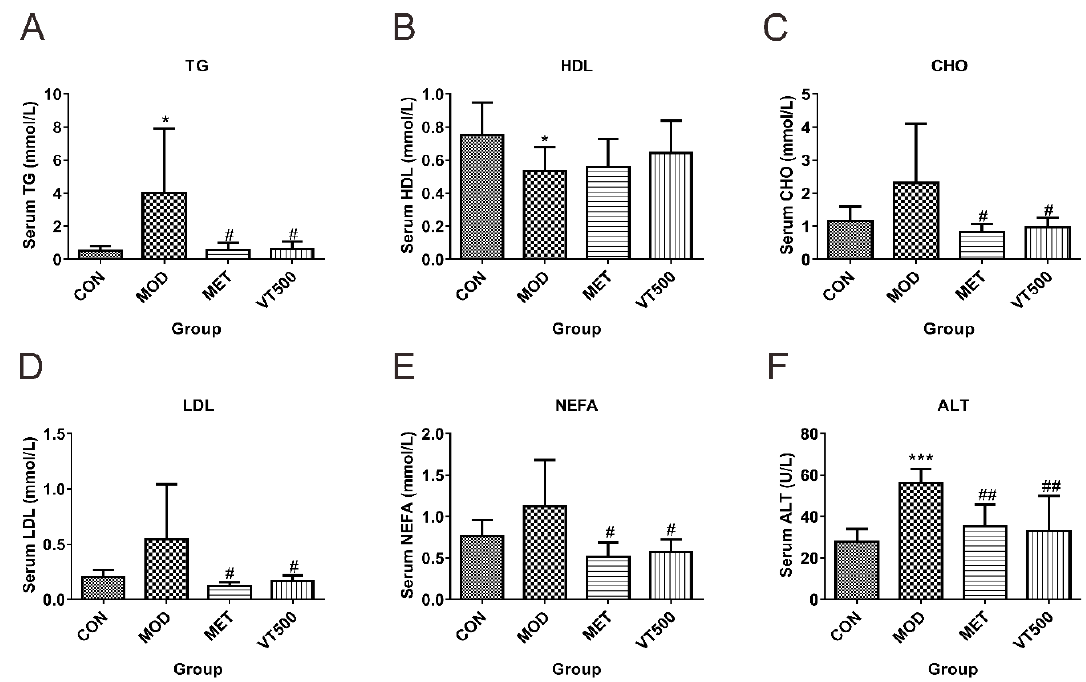
Figure 1. Effect of VT on biochemical indicators related to serum lipid and liver function in rats with T2D. Triglycerides (TG, A ), high-density lipoprotein (HDL, B ), cholesterol (CHO, C ), low-density lipoprotein (LDL, D ), nonesterified fatty acids (NEFA, E ), and alanine transaminase (ALT, F ) were measured at the end of four-weeks of treatment with VT. The data shown mean ± SD. * p < 0.05, *** p < 0.001 compared with the CON group; # p < 0.05, ## p < 0.01 compared with the MOD group, n = 6.